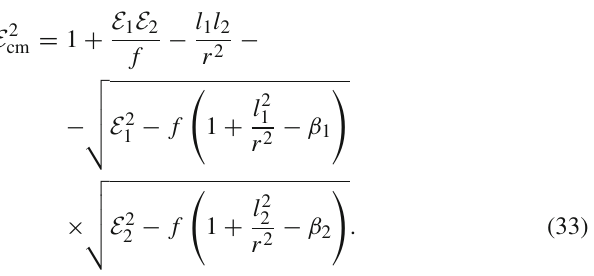
Figure 6 illustrates the radial dependence of center-of- mass energy of magnetized particles for the different values of the MOG parameter, α . The plots are taken for the values of magnetized parameter β 1 = β 2 = 1 / 2 and it was con- sidered head-on collision of particles with the specific angu- lar momentum l 1 = 2 , l 2 = − 2. One can see from Fig. 6 that the center-of-mass energy increases with the increase of the parameter α . The distance where the